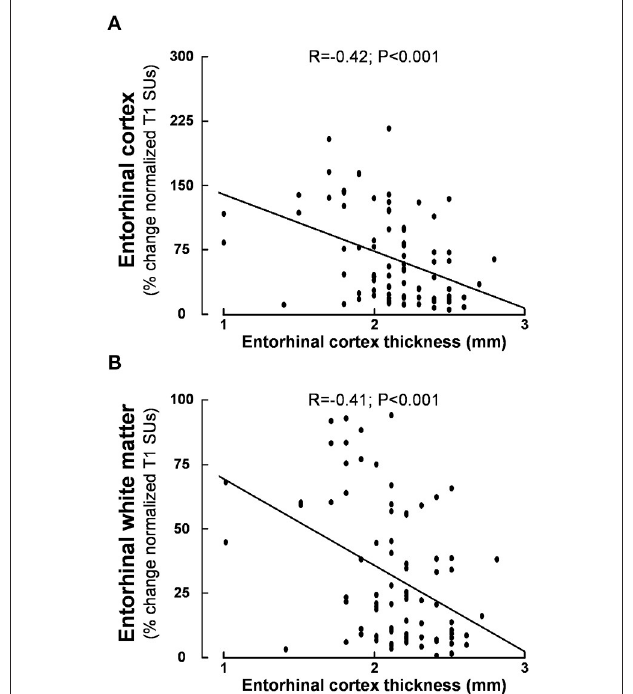
FIGURE 9 | Association between entorhinal cortex thickness and tracer enrichment at 24h within (A) entorhinal cortex and (B) entorhinal white matter. Higher values of normalized T1 signal units are indicative of reduced parenchymal clearance of the tracer. Pearson correlations with significance levels are shown. Of note, Pearson and Spearman’s correlations were similar. This plot is based on 84